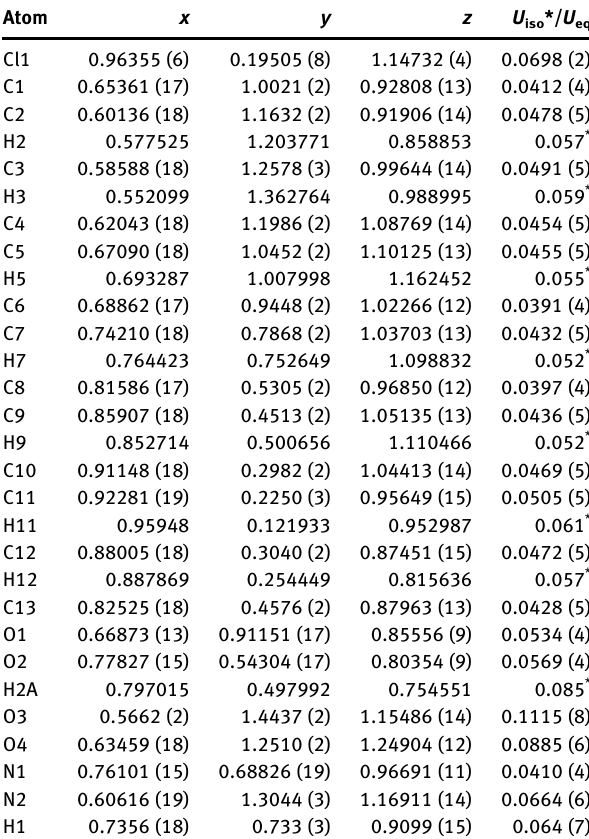
Table  : Fractional atomic coordinates and isotropic or equivalent isotropic displacement parameters (Å 